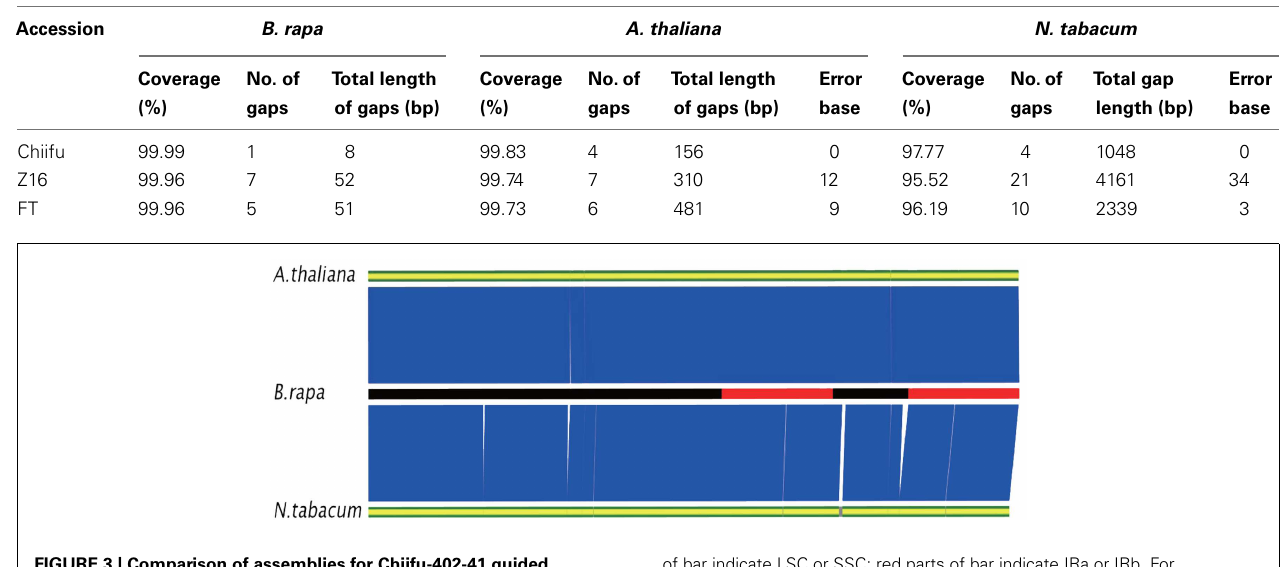
of bar indicate LSC or SSC; red parts of bar indicate IRa or IRb. For A. thaliana and N. tabacum , silver parts indicate gaps. Blue block between bars of B. rapa and A. thaliana or N. tabacum indicates identity >